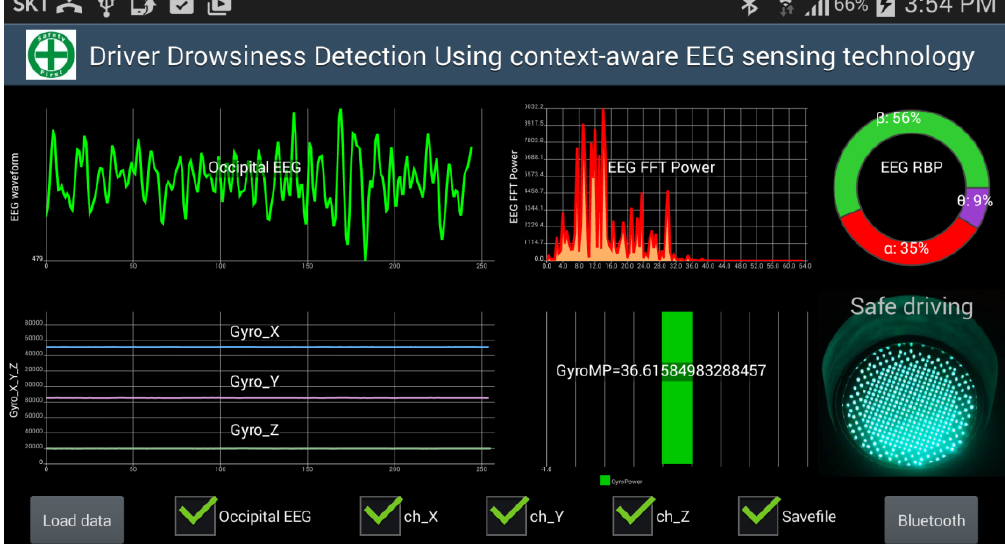
Figure 9. Screenshot of the Android smartphone application that shows the EEG and gyroscope features, the estimation of the driving status, and the raw data of EEG and 3-axis